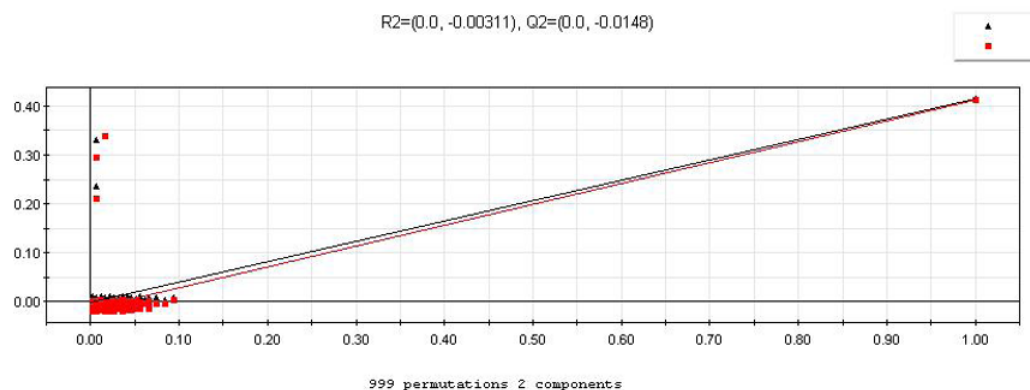
Figure 4. Y - randomization results for the final PLS-DA model. On the y-axis are represented R 2 (black triangles) and Q 2 (red squares) for the 999 models, while on the x-axis is depicted the correlation coefficient between original and permuted response data.